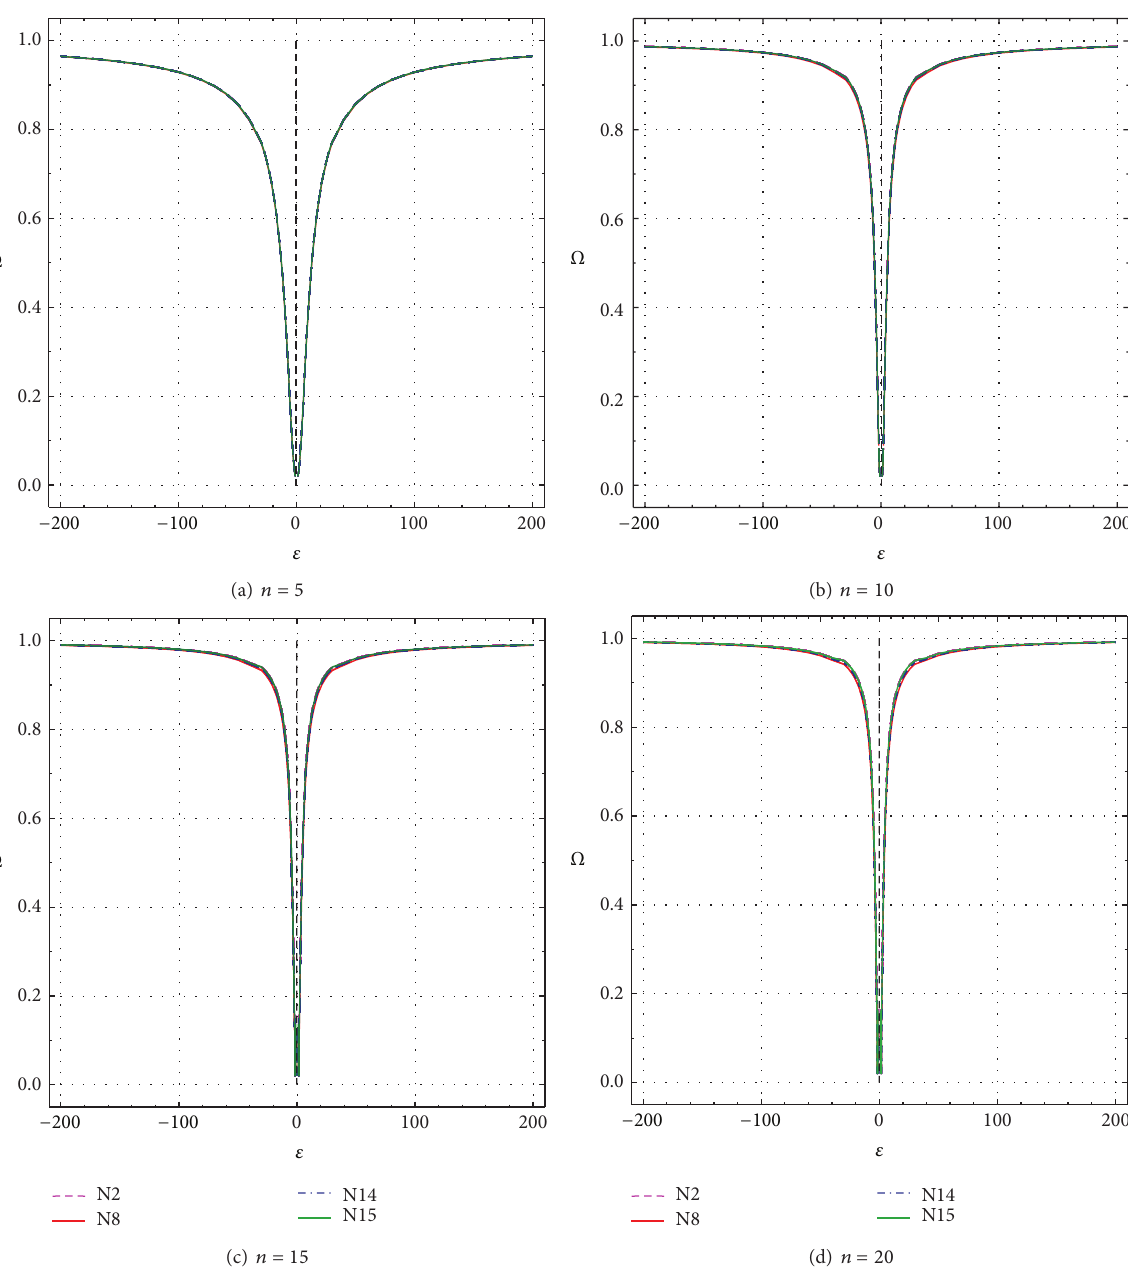
Figure 10: Power of Test ( Ω ) as a function of 𝜀 from − 1 to − 200 and +1 to +200 for all tests N2, N8, N14, and N15. (a) 𝑛 = 5 ; (b) 𝑛 = 10 ; (c) 𝑛 = 15 ; and (d) 𝑛 = 20